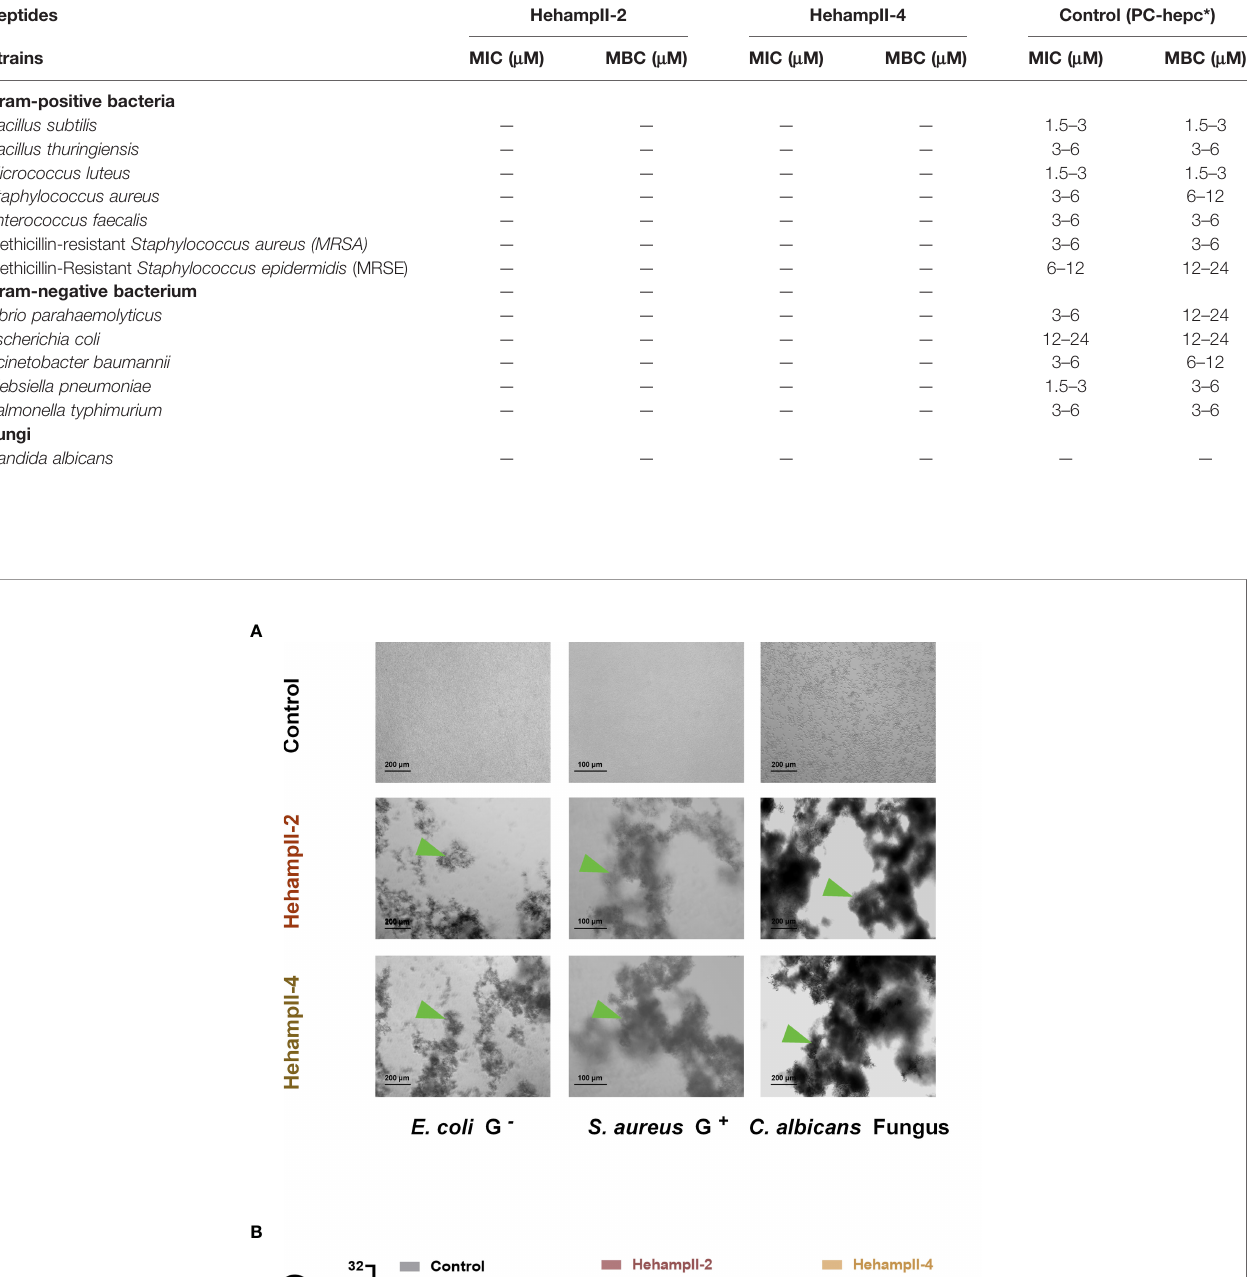
TABLE 1 | Antimicrobial activity of seahorse HampII mature peptides.